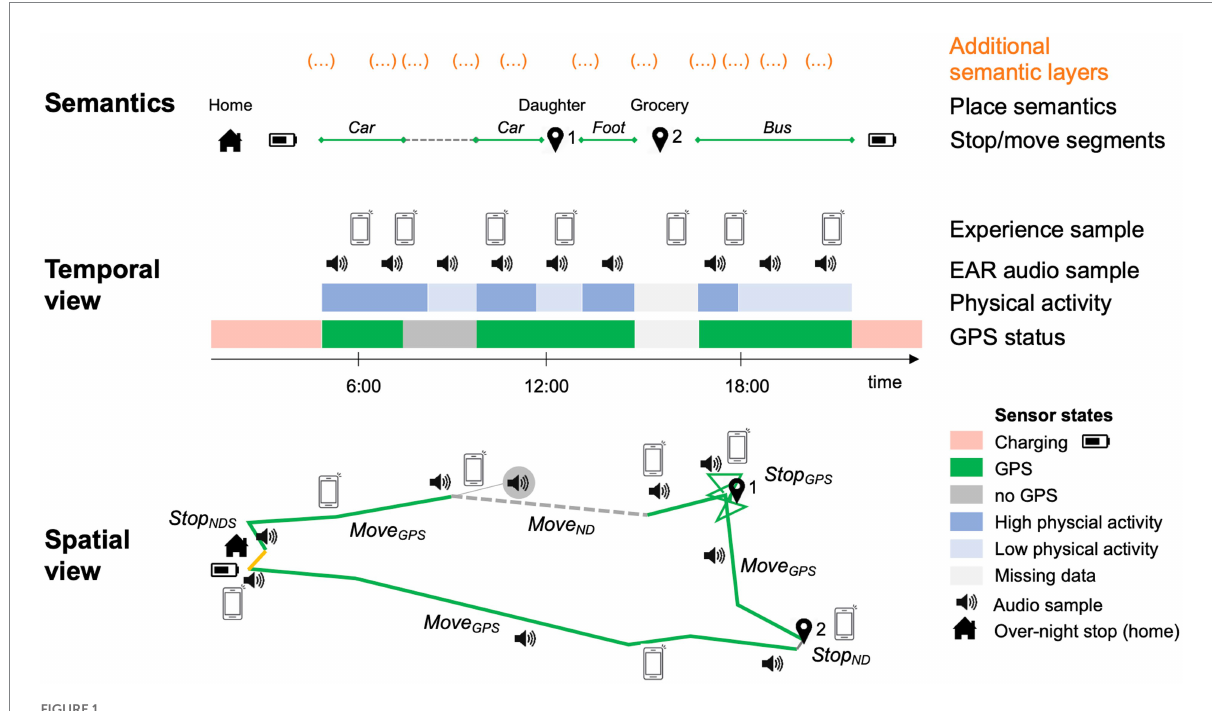
FIGURE 1 Reconstruction of spatio-temporal daily life trajectories.